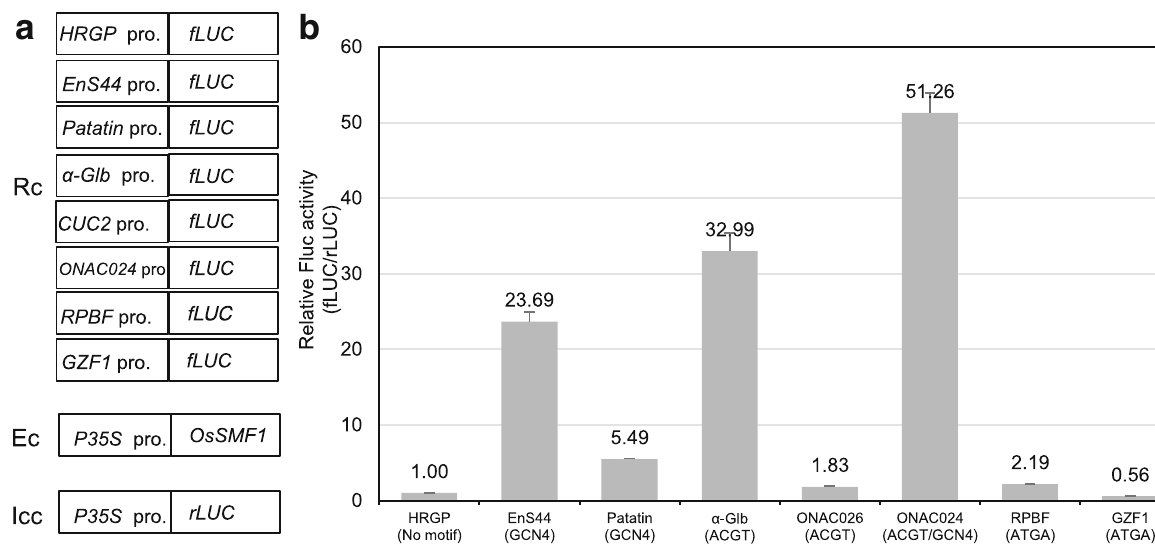
Fig. 6 Transcriptional activity analysis of OsSMF1 in rice protoplast using a dual luciferase assay system. a Construction of reporter (Rc), effector (Ec), and internal control (Icc) vectors. b P35S:SMF1 and P35S:rLUC constructs were co-transfected with TRX:fLUC , HRGP:fLUC or α -Glb:fLUC into rice protoplasts. rLUC was used as an internal control. The data are presented as the mean ± SD ( n =